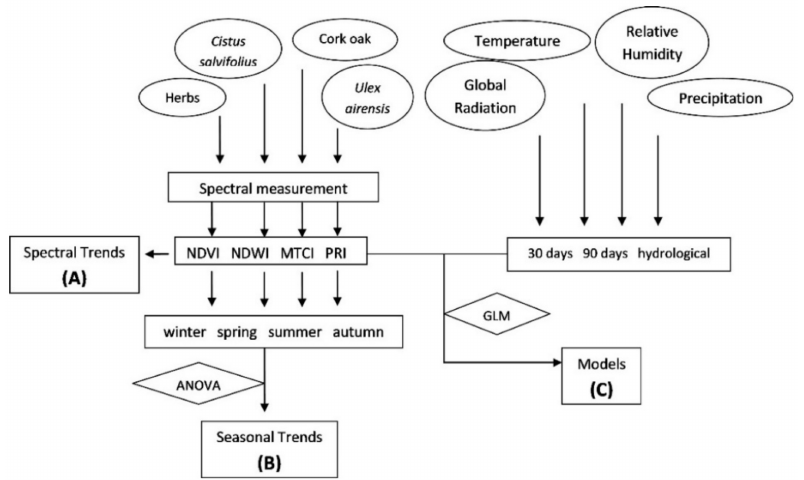
Figure 2. Workflow of the methodology, enabling building: spectral trends for VIs for each vegetation type during the period of study 2011–2017 ( A ); seasonal differences for each vegetation type ( B ); and generalized linear models of VIs for each vegetation type ( C